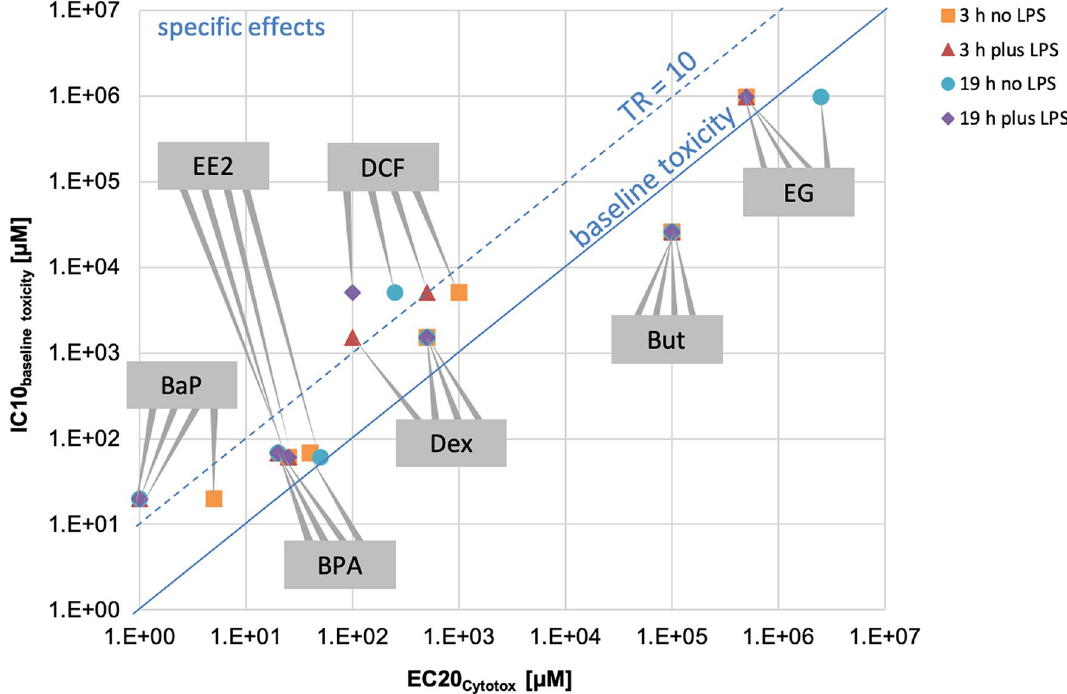
Figure 1. Comparison of the EC20 Cytotox for measured cytotoxicity with baseline toxicity predictions (IC10 baseline toxicity ). The immunotoxic chemicals are dexamethasone (Dex), diclofenac (DCF), benzo(a)pyrene (BaP), bisphenol A (BPA) and ethinylestradiol (EE2), the non-immunotoxicants are ethylene glycol (EG) and butanol (But). For BaP the highest tested concentration was used since all chemical concentrations were in the non-cytotoxic range, thus, the EC20 Cytotox was not determinable. TR ≤ 10 indicates that cytotoxicity was caused by a non-specific mode of action. TR toxic ratio, EC effect